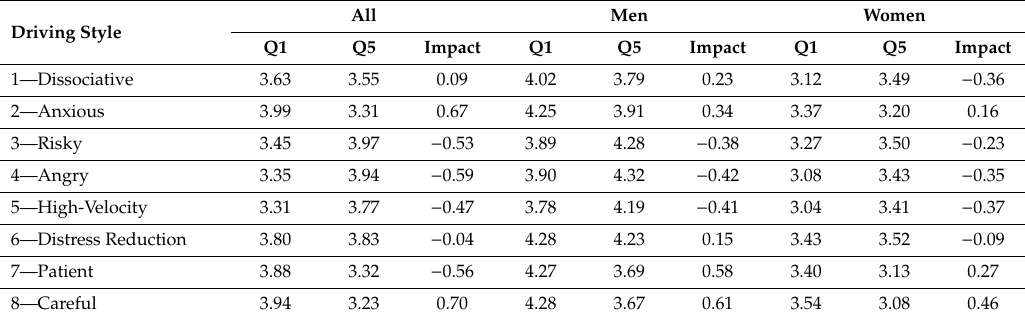
Table 12. Impact by driving style (Q1 vs. Q5) and